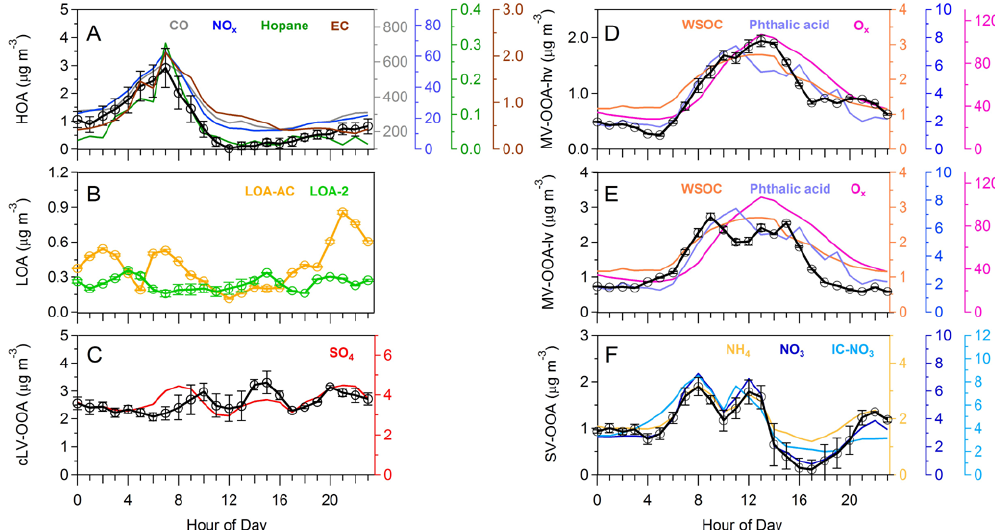
Fig. 6. Diurnal profiles of OA components identified in the 7-component TD-AMS-PMF solution. Error bars correspond to the standard error of the average hourly concentration calculated using the final, p − 1, p , and p + 1 solutions (standard errors for MV-OOA-hv and MV- OOA-lv were calculated using final and p + 1 solutions only). Concentrations of gas phase (CO, NO x , and O x ) species are reported in ppbv. Concentrations of particulate carbon (EC and WSOC) and inorganic (SO 4 , NH 4 , NO 3 , and IC-nitrate) species are reported in µgCm − 3 and µgm − 3 , respectively, while particle associated hopane and phthalic acid concentrations are reported in arbitrary units.